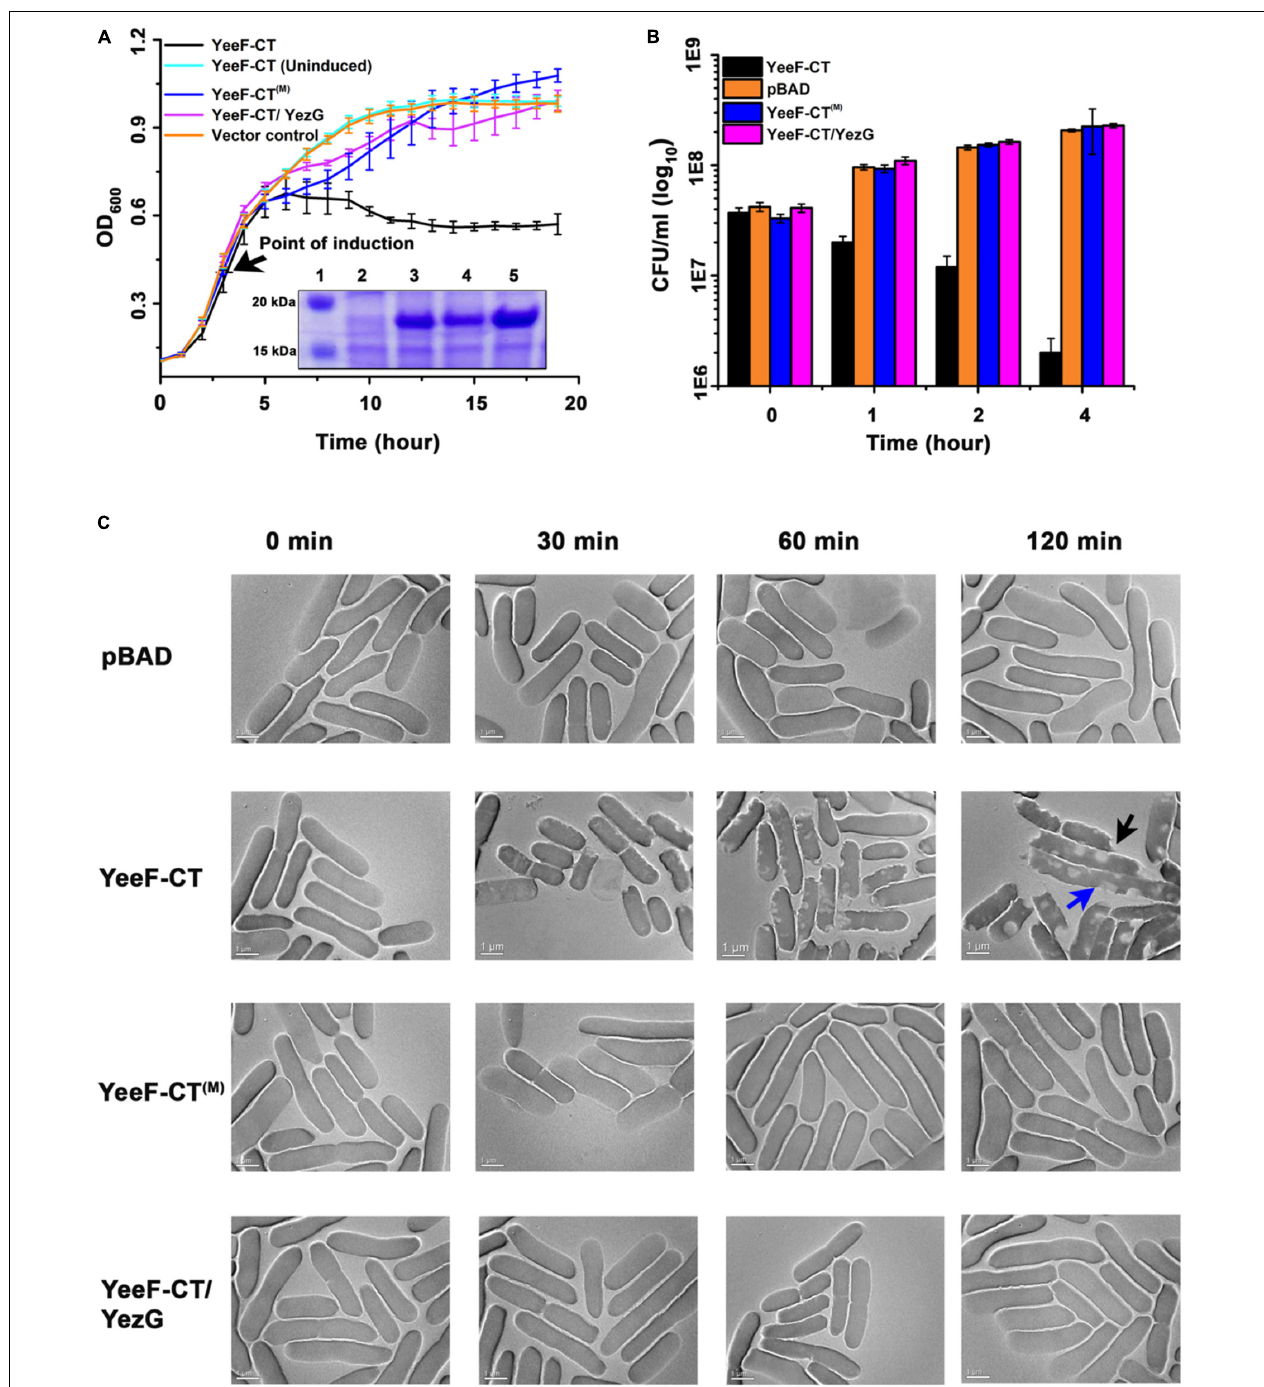
FIGURE 2 | Effect of YeeF-CT expression on bacterial growth and morphology. (A) The growth curve assay was performed in cells expressing YeeF-CT, YeeF-CT ( M ) and YeeF-CT/YezG and negative control. Cells expressing YeeF-CT shows reduction in OD 600 whereas YeeF-CT ( M ) , YeeF-CT/YezG, and negative control expression did not affect cell growth. The inset shows SDS-PAGE analysis showing the expression of proteins; (1) Protein ladder; (2) Negative control; (3) YeeF-CT; (4) YeeF-CT ( M ) and; (5) YeeF-CT/YezG. Since the molecular weight of YeeF-CT and YezG are apparently similar i.e., 18.9 and 19.2 kDa, respectively, so they appeared as a single band. (B) The CFU counting analysis also correlates well with the growth curve analysis. (C) TEM imaging of cells harboring plasmid only (upper panel), expressing YeeF-CT (second panel), YeeF-CT ( M ) (third panel) and YeeF-CT/YezG (lower panel). While cells imaged at 0 min show smooth surface in all the samples, 30 min post-induction, cells expressing YeeF-CT appears to have some defects on the surface, which becomes quite evident at the 60 and 120 min post-induction. The blue arrow shows cell elongation and black arrow shows a defect in the cell surface. The cells expressing YeeF-CT ( M ) and YeeF-CT/YezG appeared to have a smooth surface and intact cell wall at all the time